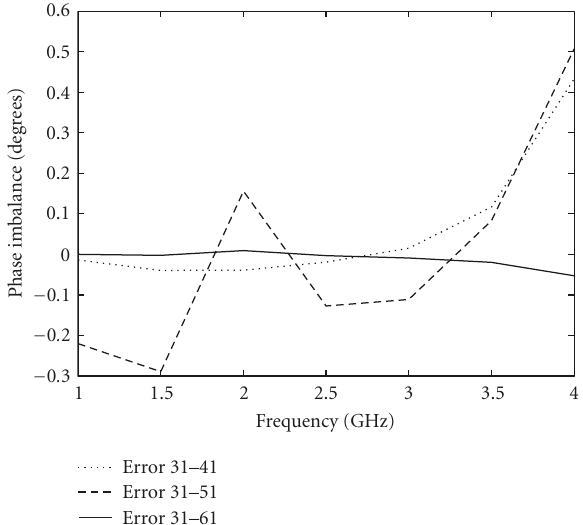
Figure 13: The predicted phase imbalance of an ideal 2 × 2 coupler.